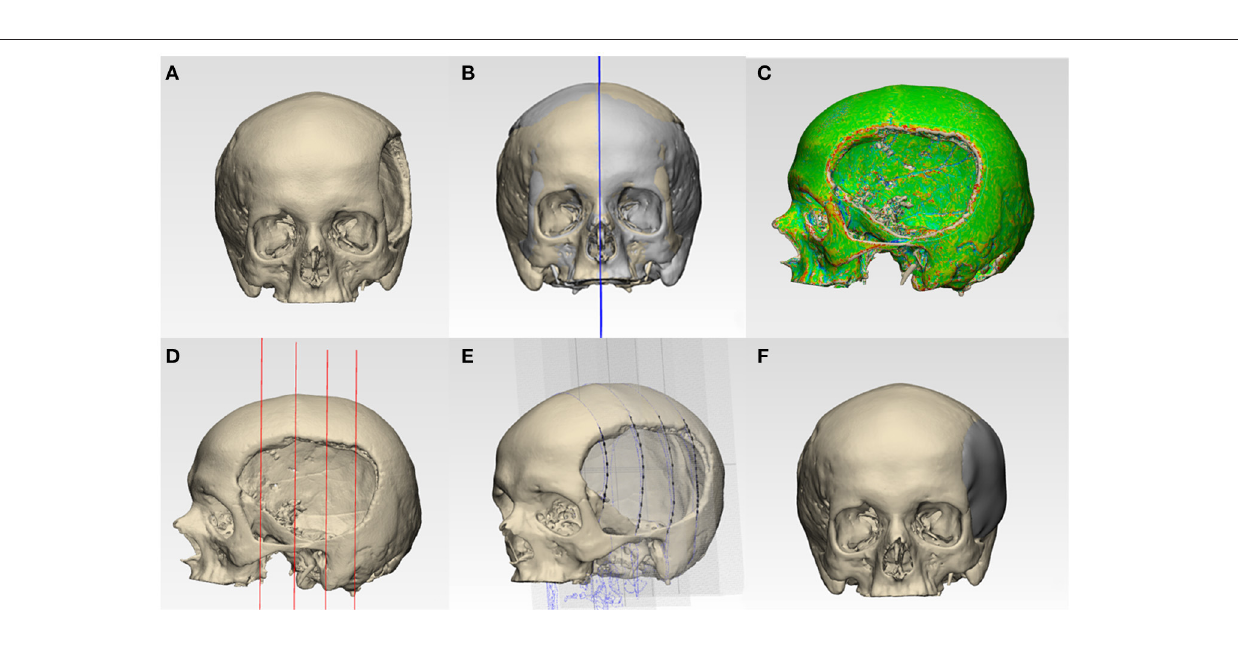
FIGURE 1 | Medical image processing for the generation of a three-dimensional (3D) volumetric reconstruction of the patient’s skull with unilateral cranial deformity. (A) Coronal view. (B) Axial view. (C) Sagittal view. (D) Skull 3D volumetric reconstruction.